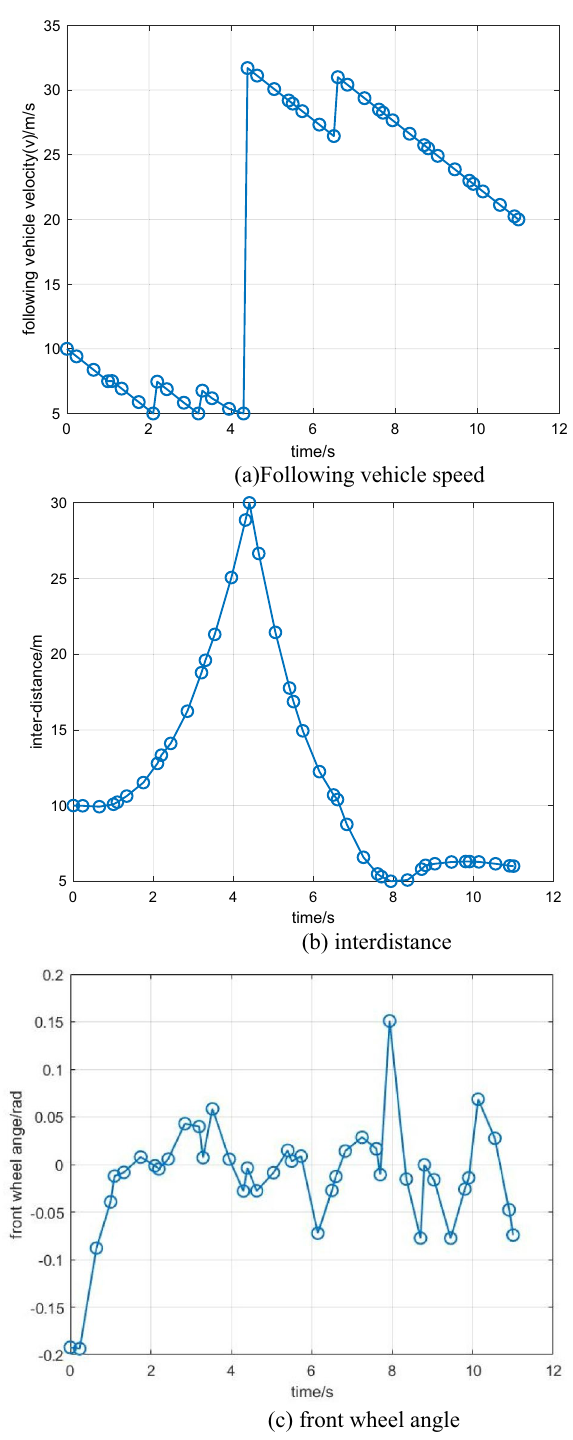
Figure 5. ( a ), ( b ), and ( c ) Driving states of the following